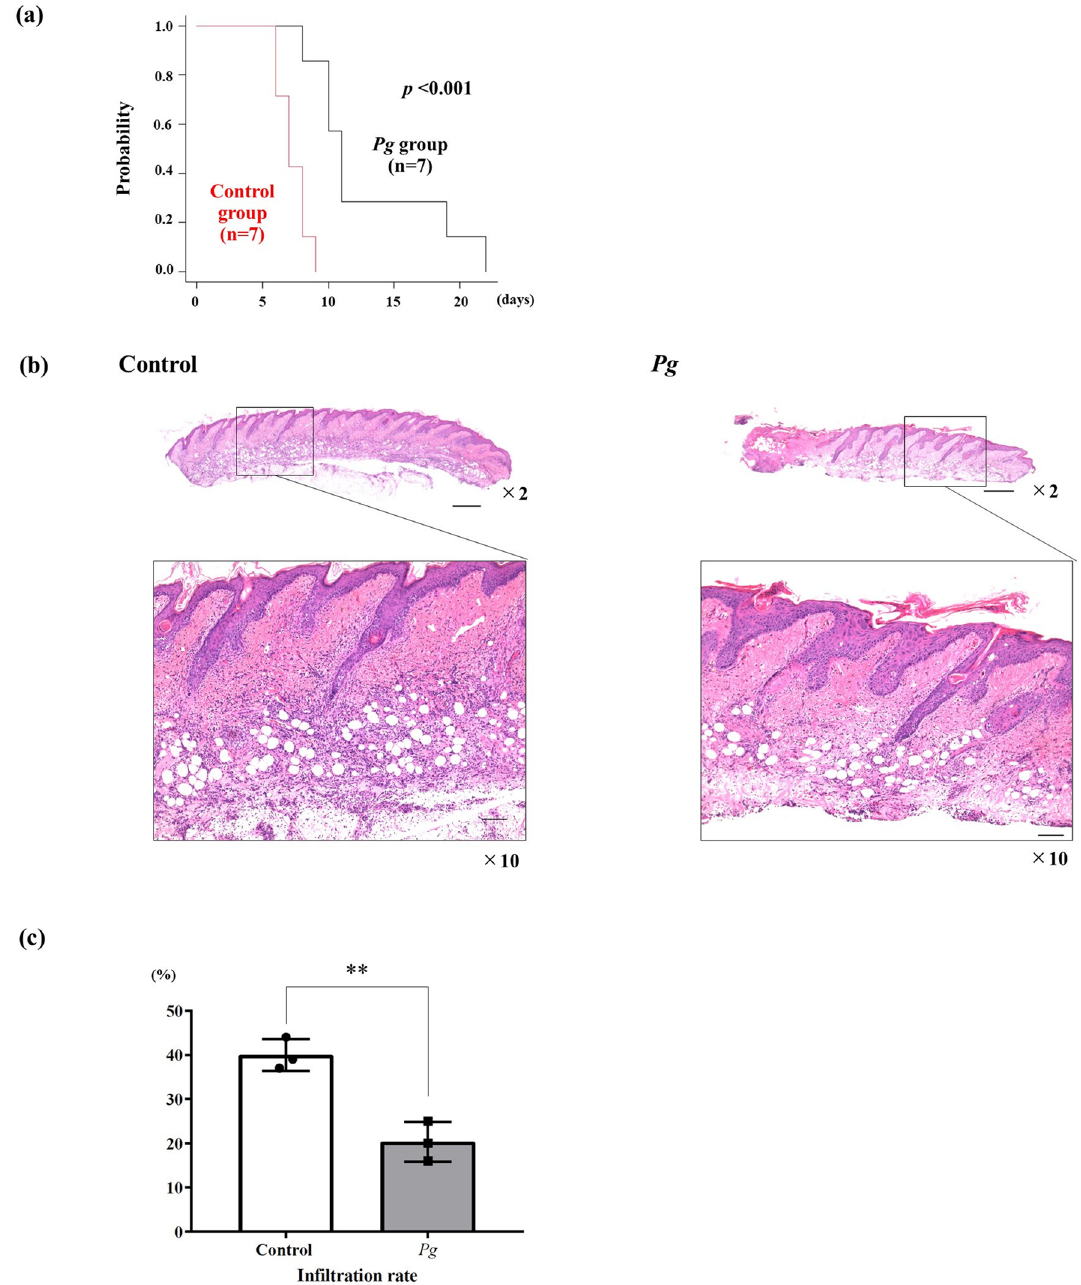
Figure 5. Skin graft survival and pathological changes in skin grafts in both groups. ( a ) Skin graft survival between the groups (each group: n = 7). On day 8 after skin grafting, the degree of inflammation of the skin graft was evaluated pathologically (hematoxylin/eosin staining). ( b ) × 2 magnification. The bar scale is 500 µm, × 10 magnification The bar scale is 100 µm. ( c ) Percentage of inflammatory cell infiltration in both groups (each group: n = 3). * p < 0.05, ** p <